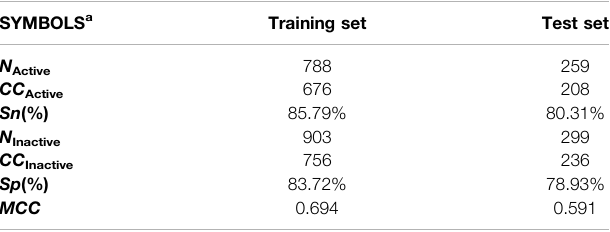
TABLE 2 | Internal quality and predictive performance of the mt-QSAR- MLP model. SYMBOLS